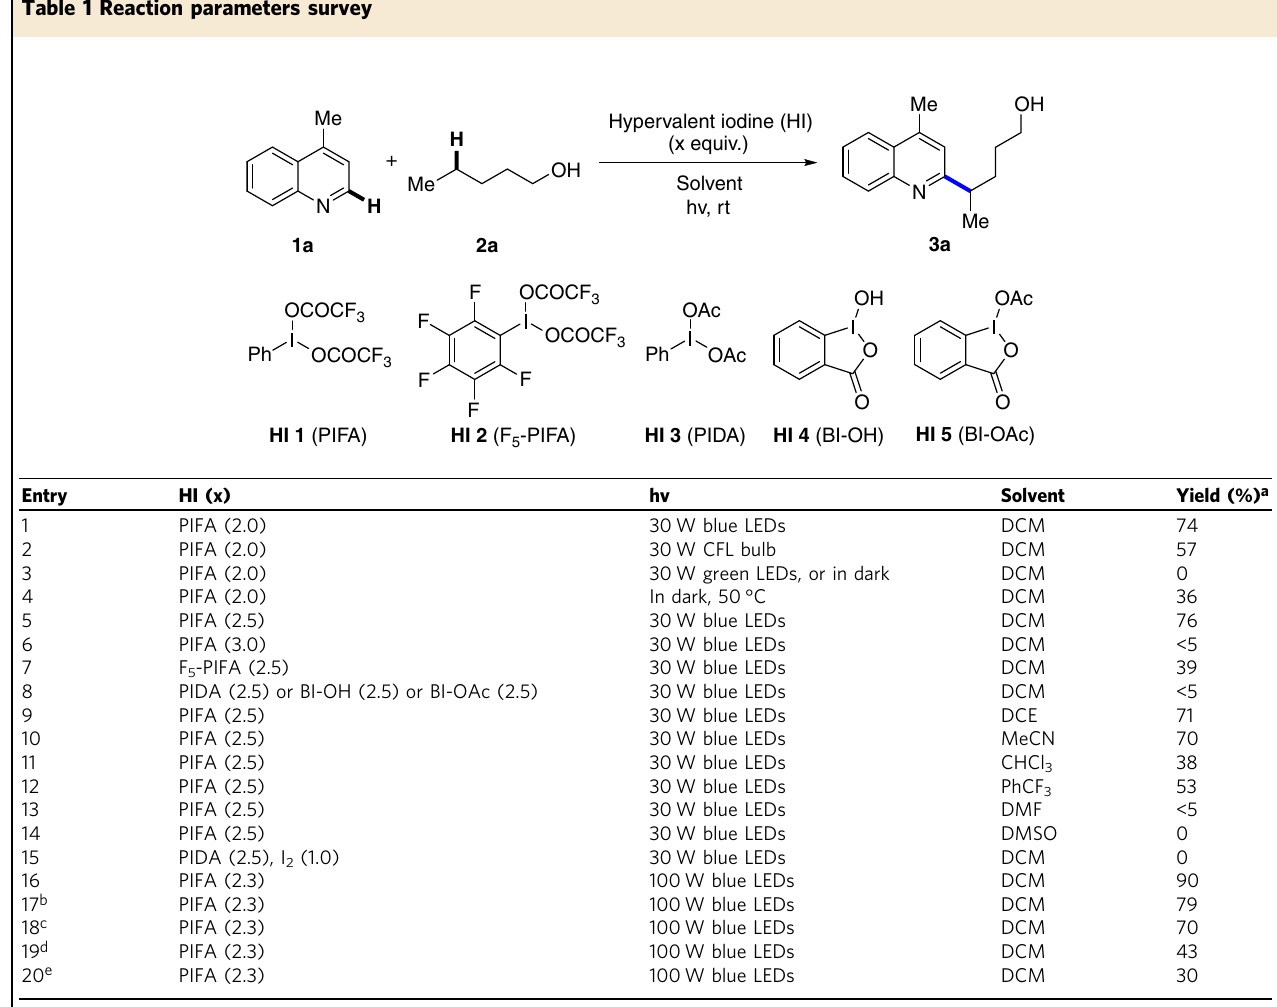
Table 1 Reaction parameters